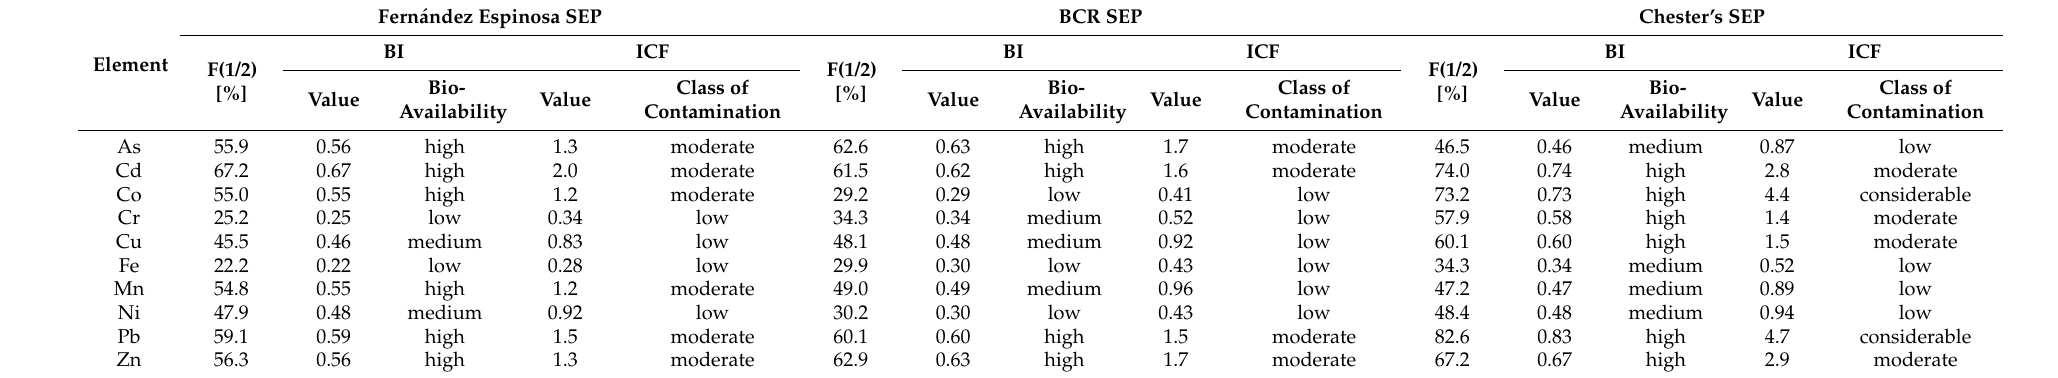
Table 6. Mean proportion of the non-resistant fraction of ten PTEs in urban particulate matter worldwide, and corresponding bioavailability indices and individual contamination